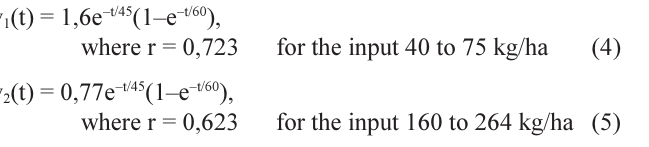
Mean Daily Emissions and Total Loss of N Applied to Agricultural Lands, N Soil